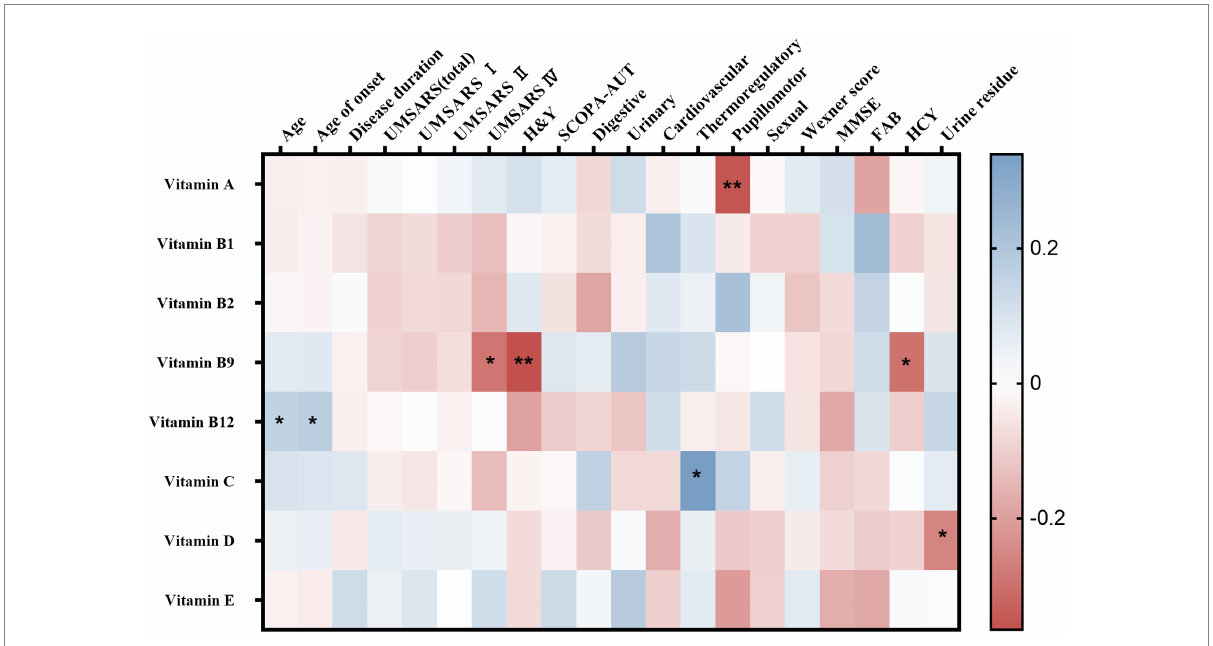
FIGURE 3 Heatmap for correlation analysis between different vitamins and clinical characteristics of multiple system atrophy (MSA). UMSARS, the Unified MSA Rating Scale; H&Y, Hoehn and Yahr Parkinson’s disease staging scheme; SCOPA-AUT, the Scales for Outcomes in PD-Autonomic questionnaire; MMSE, Mini-Mental State Examination score; FAB, Frontal Assessment Battery score. * p < 0.05; ** p <